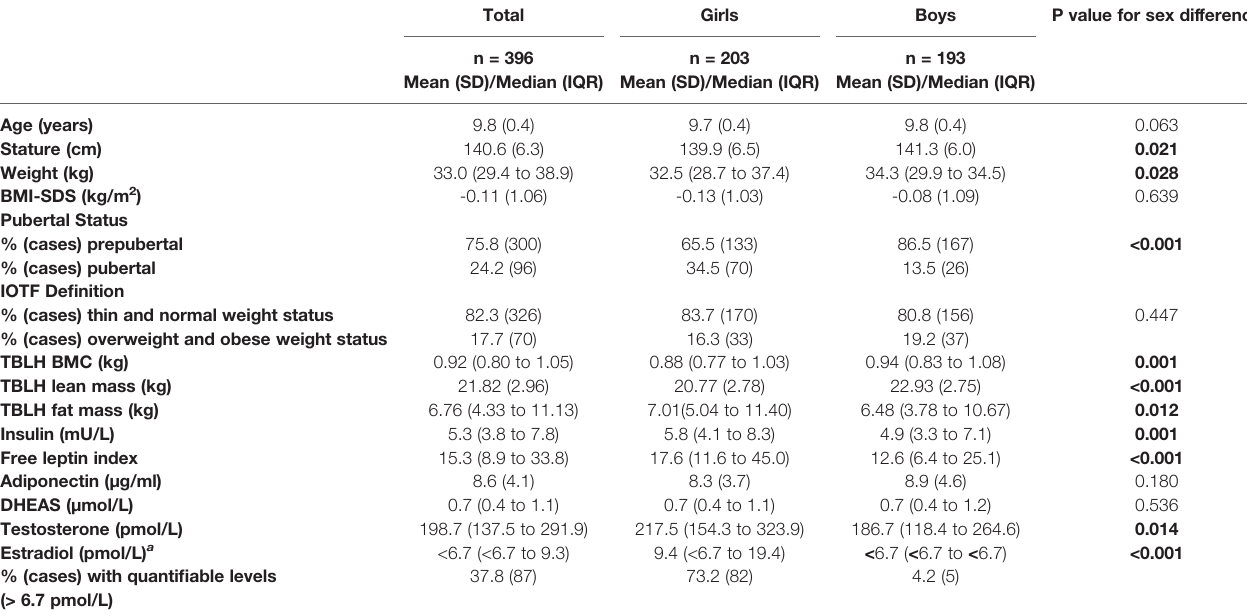
TABLE 1 | Descriptive characteristics of children.